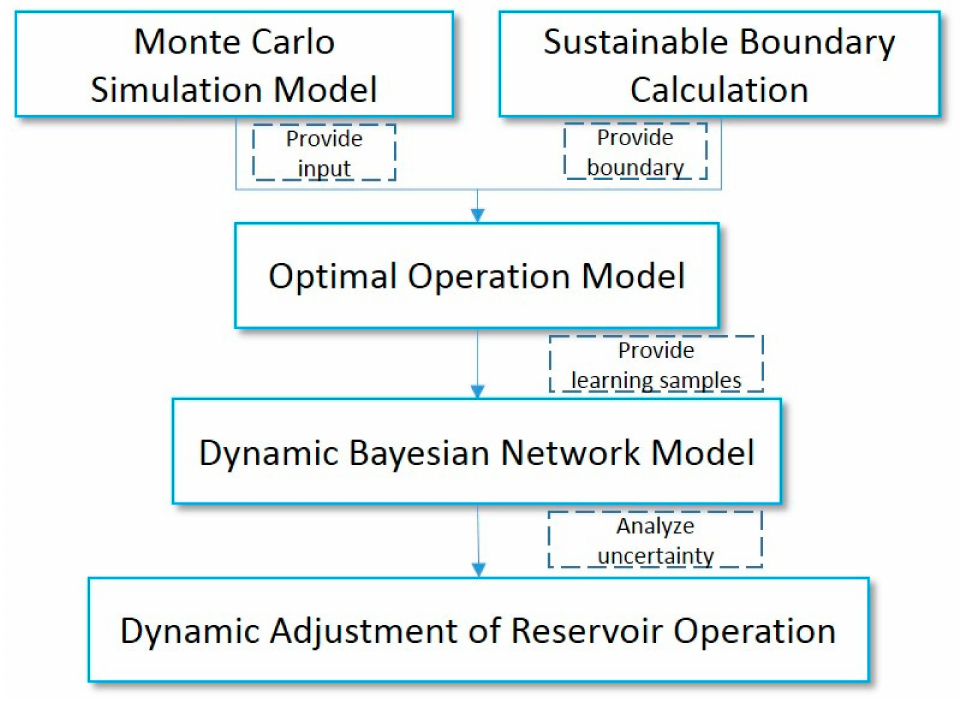
Figure 1. Framework of the proposed